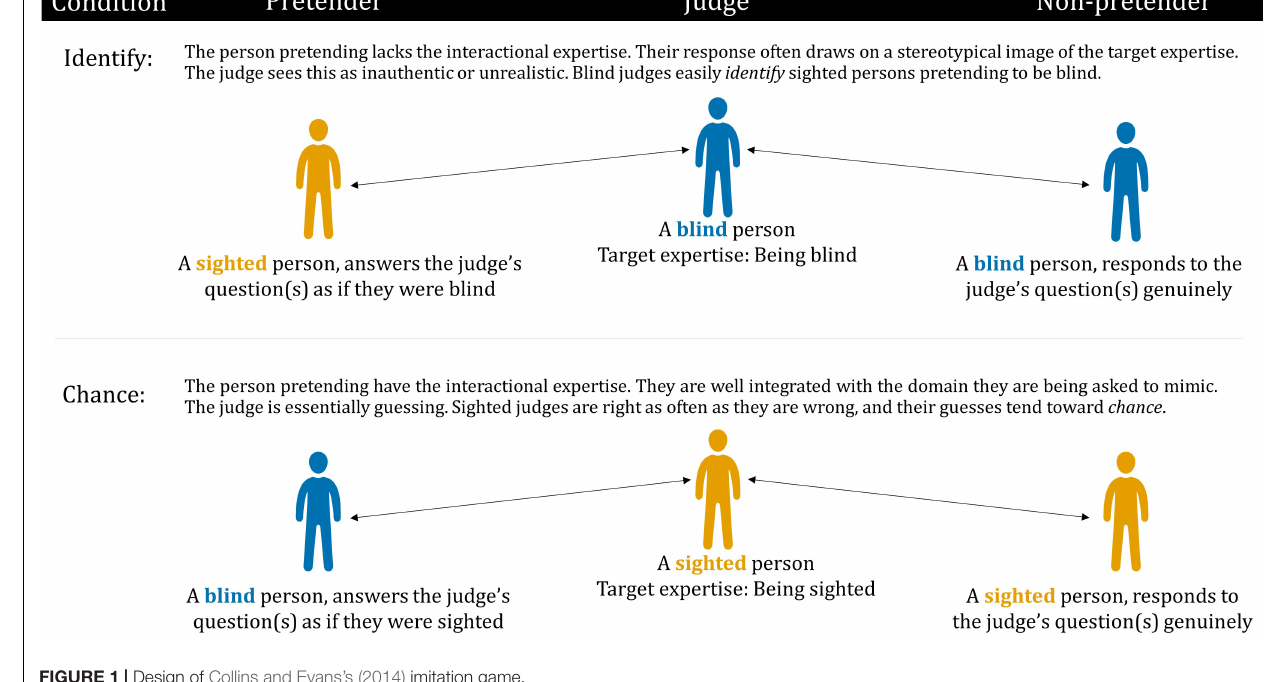
FIGURE 1 | Design of Collins and Evans’s (2014) imitation